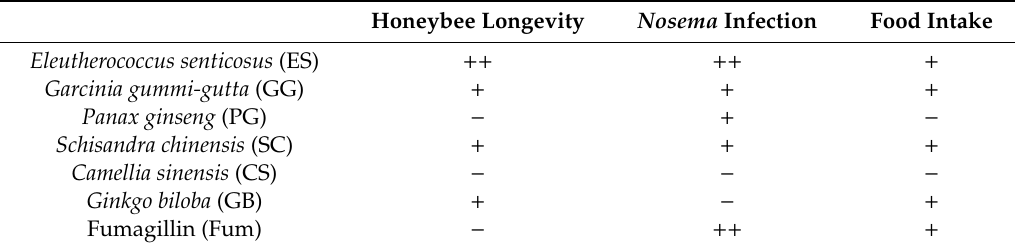
Table 1. Results of the cage tests: Screening of commercial plant extracts. The honeybee longevity: ++ the extract which was most e ffi cient in the prolongation of the honeybee lifespan, + the extract prolonged the honeybee lifespan in comparison to the control group, − the extract reduced the honeybee lifespan in comparison to the control group. Reducing the level of nosemosis: ++ the extract which was most e ffi cient in reducing the level of nosemosis, + the extract reduced the level of nosemosis in comparison to the control group, − the extract did not reduce the level of nosemosis in comparison to the control group. Food intake: + sucrose syrup with addition of the extract was consumed in a similar level as the pure sucrose syrup in the control group, − the extract was reluctantly consumed by honeybees in comparison to the control